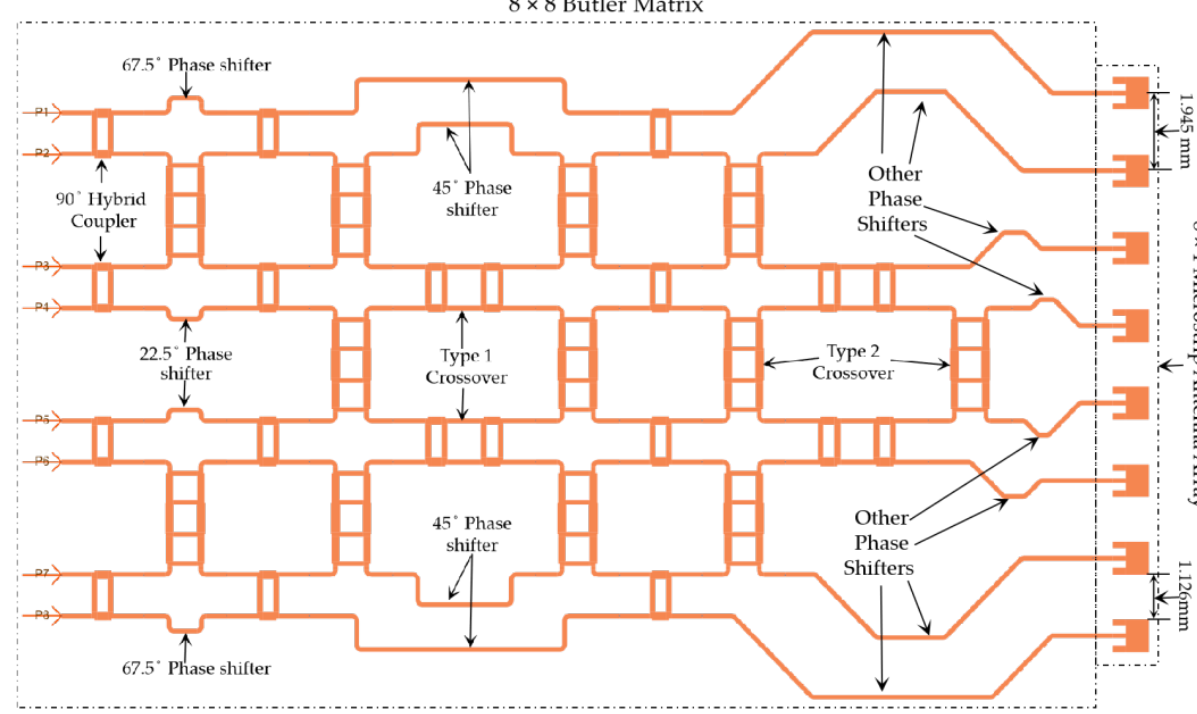
Figure 22. An 8 × 8 Butler matrix with a microstrip antenna array of eight elements in ADS.